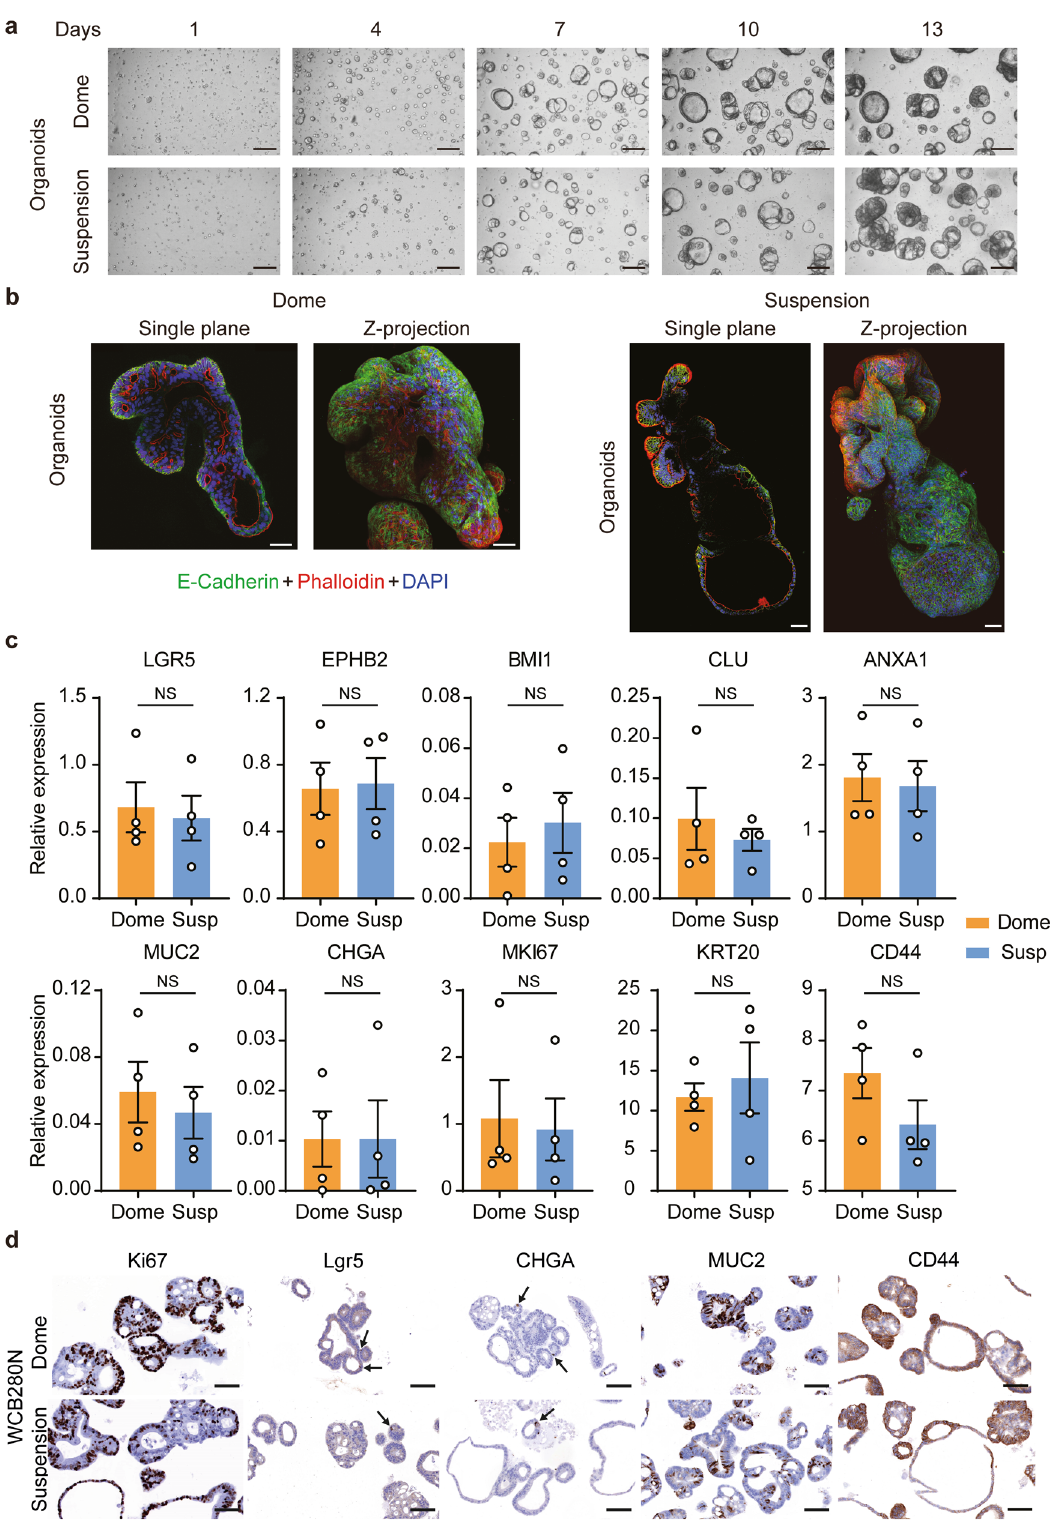
qRT-PCR analysis of organoids revealed broad concordance of expression patterns between LVM suspension and dome cultures for markers of crypt base columnar stem cells ( LGR5, EPHB2 ), quiescent stem cells ( BMI1 ), revival stem cells ( CLU and ANXA1 ), crypt base cells (CD44), transient amplifying cells ( MKI67 ), goblet cells ( MUC2 ), enteroendocrine cells ( CHGA ), and mature enterocytes and goblet cells ( KRT20 ). Corresponding results